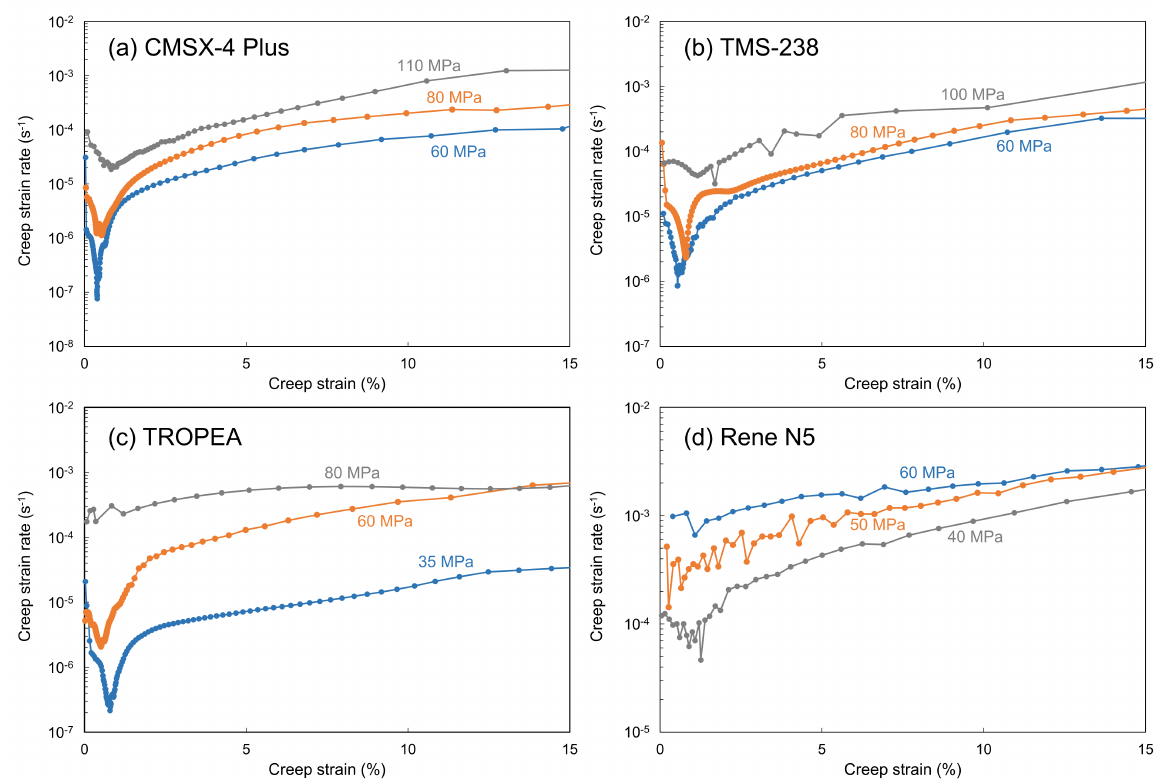
Figure 5. Creep strain rate curves of CMSX-4 Plus ( a ), TMS-238 ( b ), TROPEA ( c ), and Rene N5 ( d ) tested at 1250 ◦ C with different applied stresses.